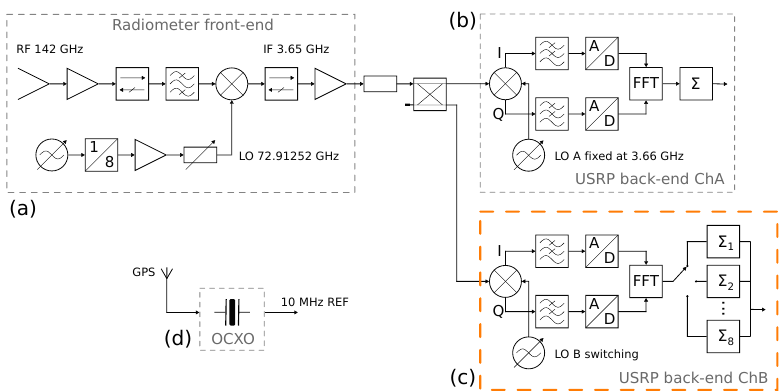
Figure 1. Schema of the WIRA-C radiometer front-end ( a ) and the back-end with spectrometer ChA ( b ) with fixed LO and changed ChB ( c ) with switching LO. All LO clocks are connected to the same GPS disciplined Oven Controlled Crystal Oscillator (OCXO) ( d ). IF, Intermediate